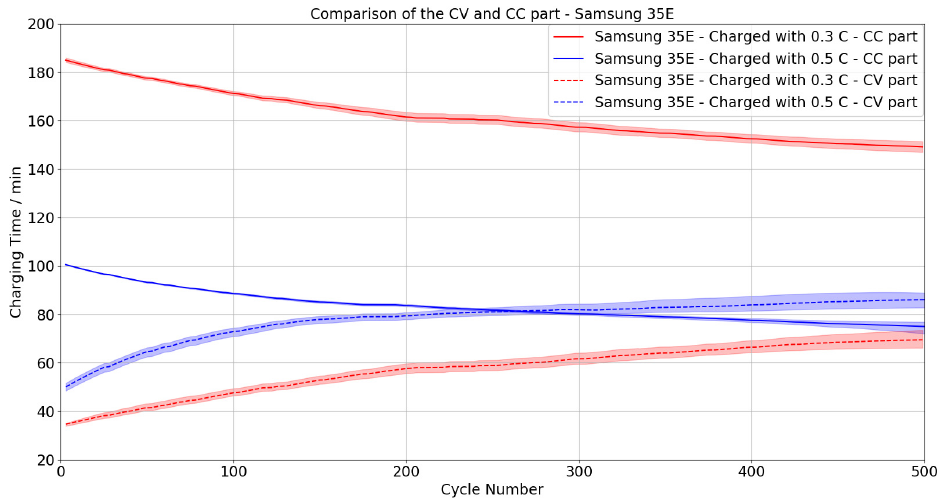
part for Samsung 25R. for Samsung 25R. part for Samsung 50E.